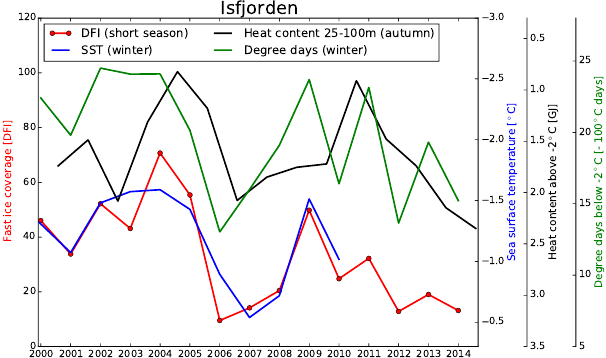
Figure 8. Isfjorden’s (red) “days of fast ice” (DFI) values of the short season compared to (blue) winter sea surface temperature (SST), (black) autumn heat content above -2 ◦ C of the 25–100m depth water column and (green) winter negative degree days be- low -2 ◦ C. Winter SST values represent the mean for the period January–April at 78.25 ◦ N, 14.75 ◦ E. Heat content values are cal- culated using the mean temperature profile during autumn (July– September) at the Isfjorden mouth area. Negative degree days have been derived from temperature measurements at the Svalbard air- port station (78.25 ◦ N, 15.50 ◦ E). Note the reversed SST and heat content axis.